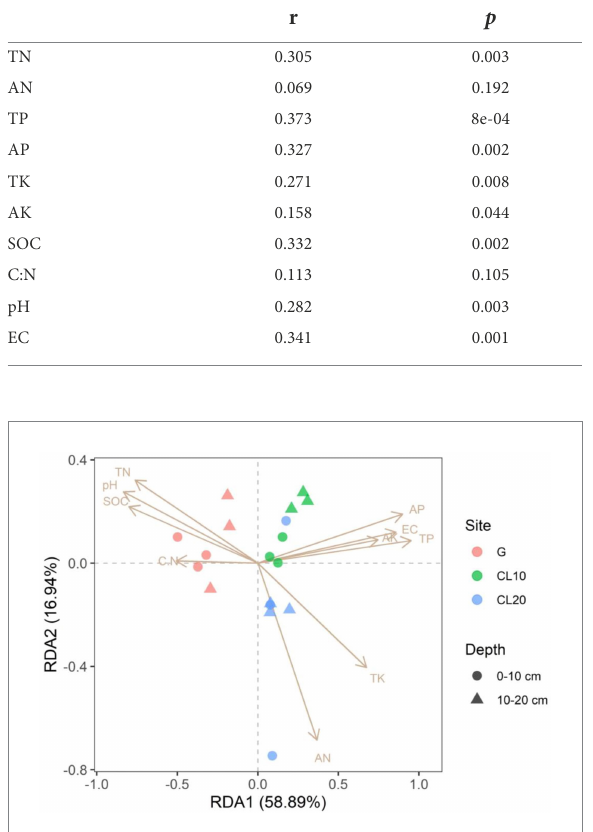
FIGURE 6 Redundancy analysis (RDA) of bacterial community composition and soil properties in different land use types and